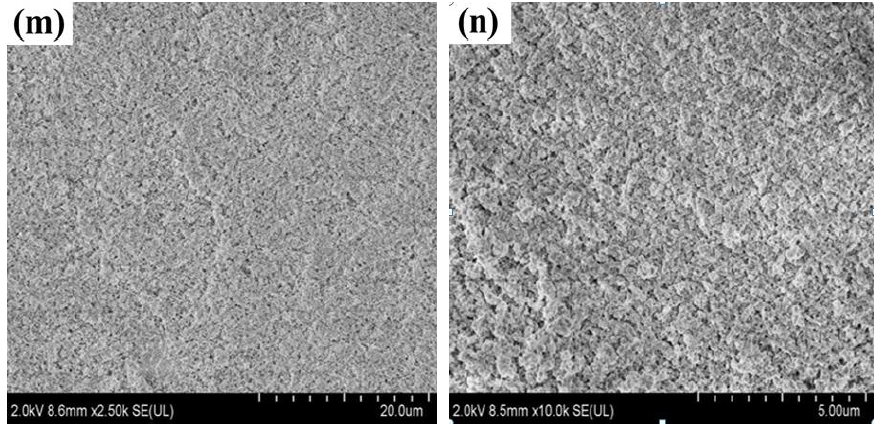
Figure 2. SEM images showing micromorphology of MOC ( a , b ) cured for 28 days at room temper- ature and then heated at ( c , d ) 100 °C, ( e , f ) 200 °C, ( g , h ) 300 °C, ( i , j ) 400 °C, ( k , l ) 450 °C, and ( m , n ) 500 °C.